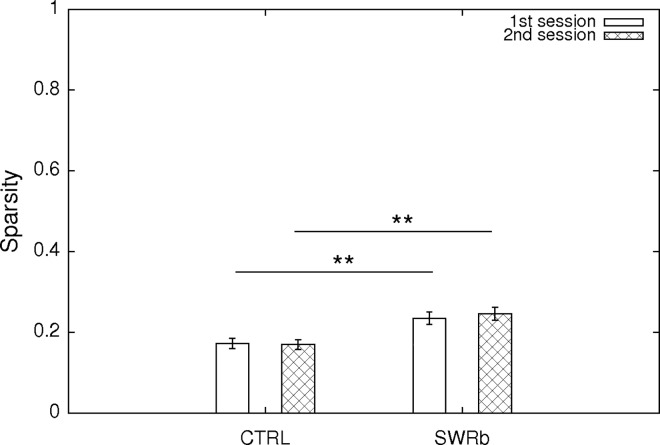
Sparsity of the cells.Mean ± SE of the sparsity of the CA1 pyramidal neurons at first exposure (open bars) and second exposure (cross-hatched bars) to the same environment. Sparsities at the first exploration session are significantly different between the control and SWR-block condition (p = 0.004; Oneway ANOVA), as well as for the second exploration session (p = 0.002; Oneway ANOVA). 117 (SWR block) + 116 (CTRL) pyramidal cells were used for this analysis.